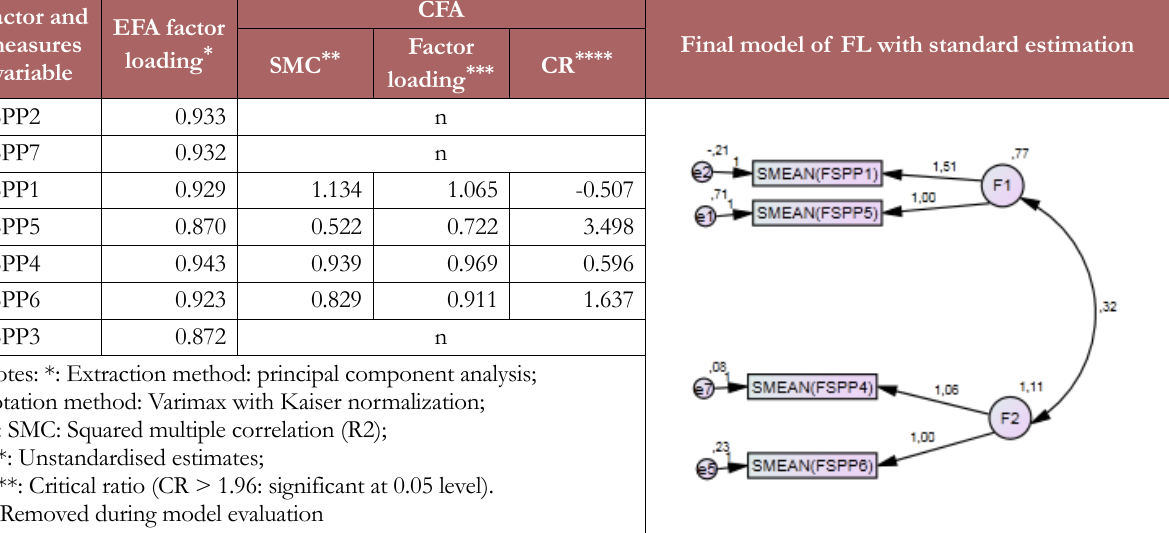
Table 21. EFA and CFA of the FSPP